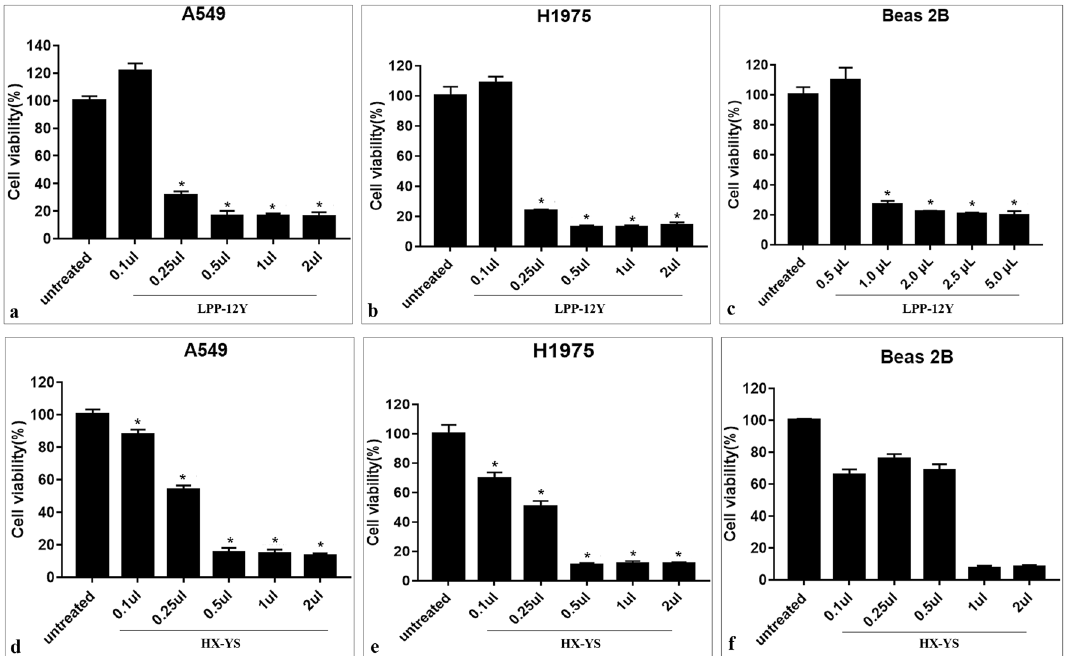
Figure 9. Histogram showing cellular viability of A549 and H1975 and Beas 2B cells after exposure to different concentrations of AgNPs. The untreated cells by AgNPs as control is